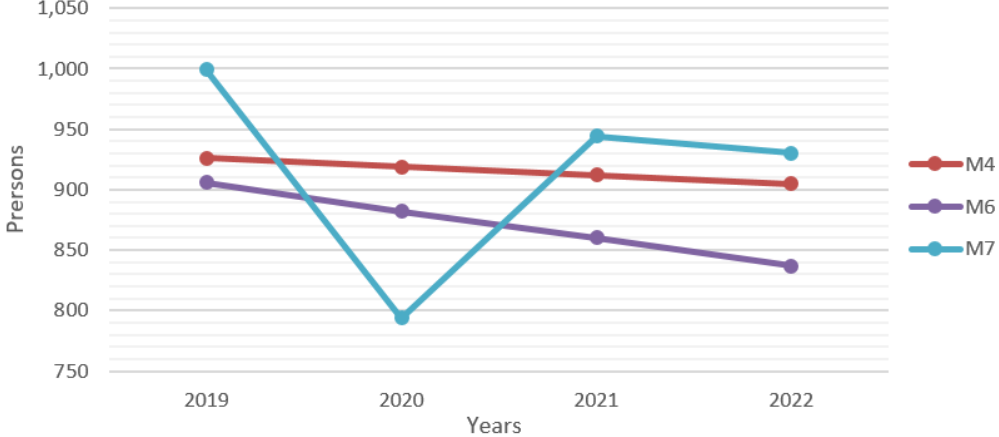
Figure 5. Accident at work forecasts for M4, M6 and M7 models.